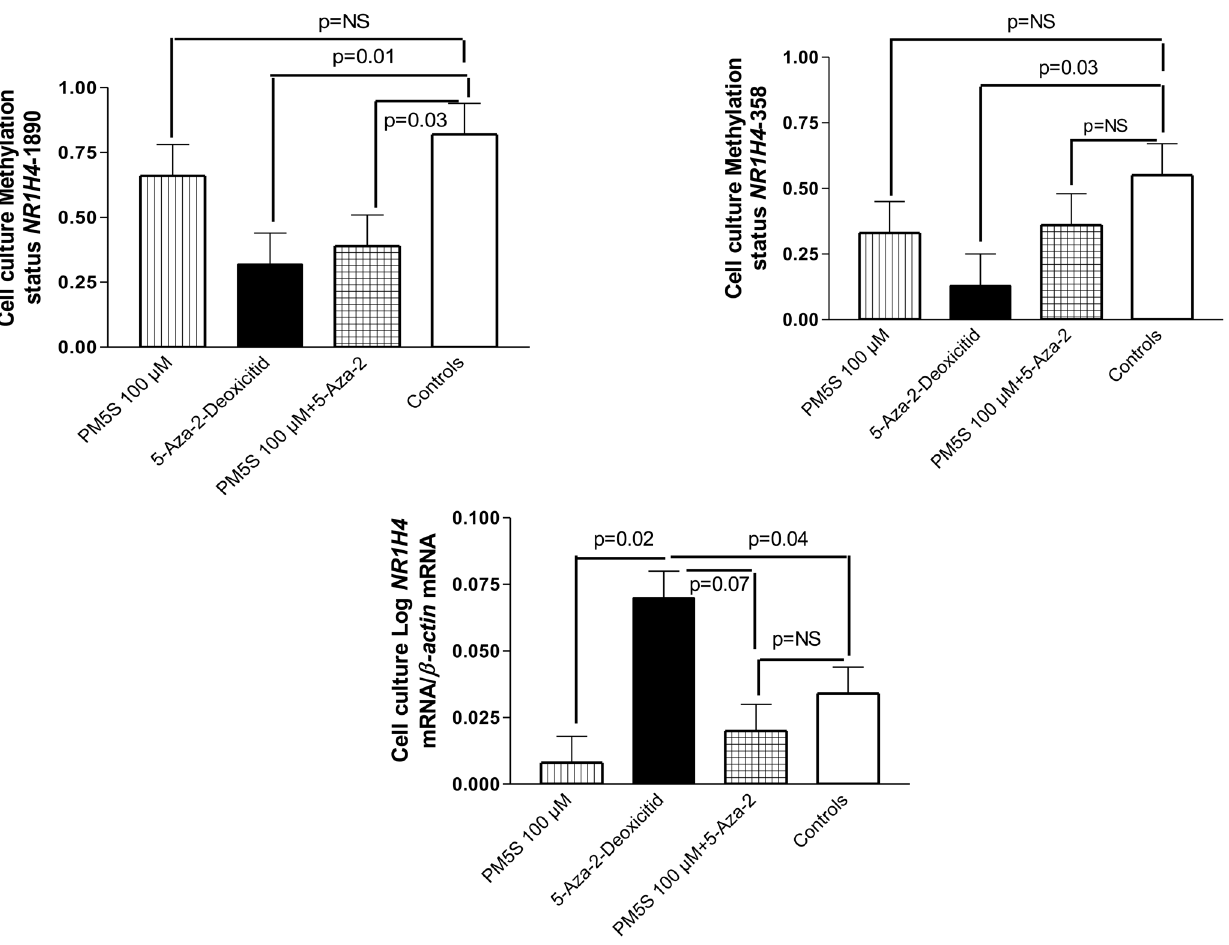
Figure 2. In vitro exploration of the effects of the progesterone metabolite, epiallopregnanolone sulfate PM5S, on the status of CpG methylation of the FXR / NR1H4 gene promoter. Huh7 human hepatoma cells were treated with an agent that inhibits DNA methylation (5 m M 5-Aza-2 9 -deoxicitidine), a sulphated progesterone metabolite, a reported FXR inhibitor (PM5S, 5 a -Pregnan-3 b -OL-20-one sulfate, sodium salt, also known as epiallopregnanolone sulfate), and a combination of both agents. Controls cells did not receive any treatment. At the top of the figure, we show data about methylation changes at the proximal and distal FXR / NR1H4 gene promoter, at the bottom we show changes in the FXR / NR1H4 mRNA levels.